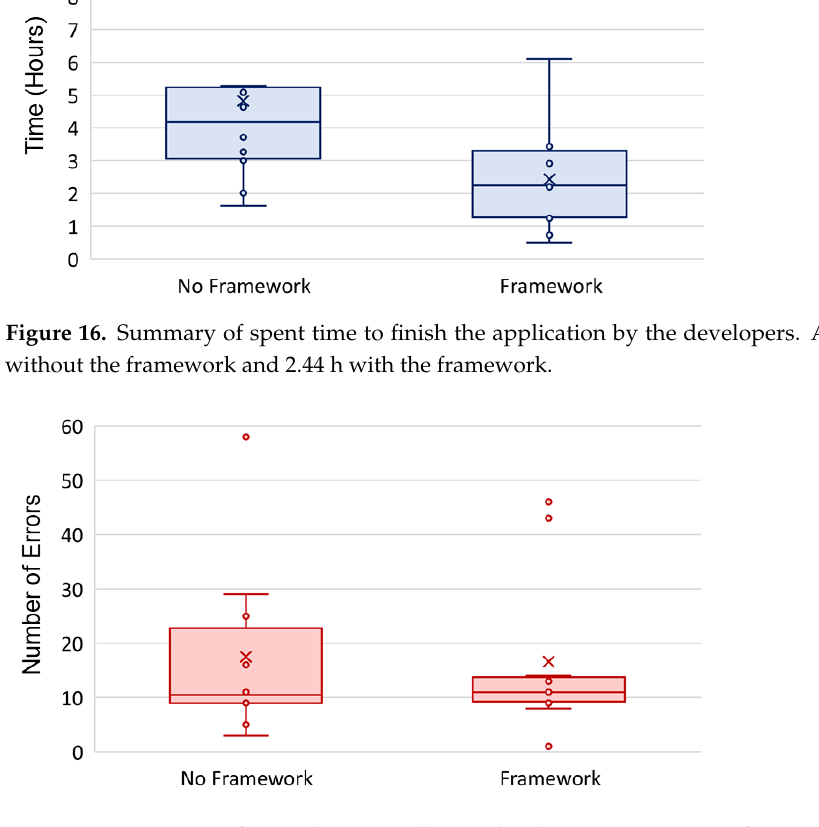
Figure 17. Summary of compiler errors during development. Average of 17.5 errors without the framework and 16.6 errors with the framework.